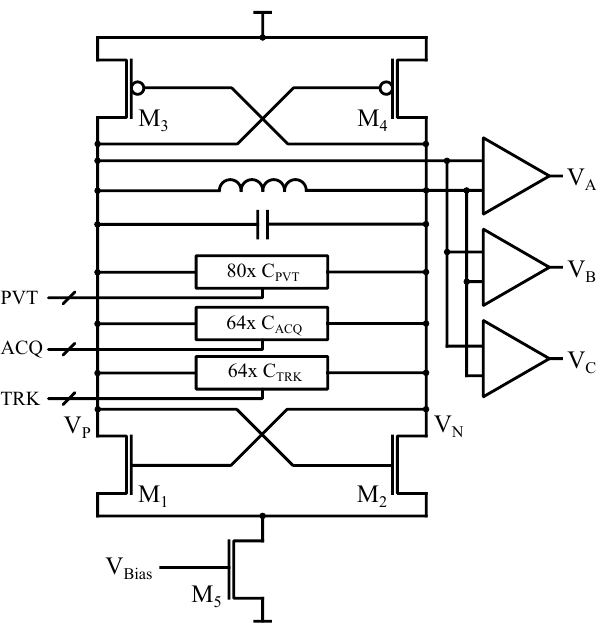
Figure 3. Schematic of the digitally controlled LC oscillator with redundant output buffers. Its frequency is controlled using PVT, acquisition (ACQ) and tracking (TRK) banks. Only the tracking bank is used for closed-loop control.